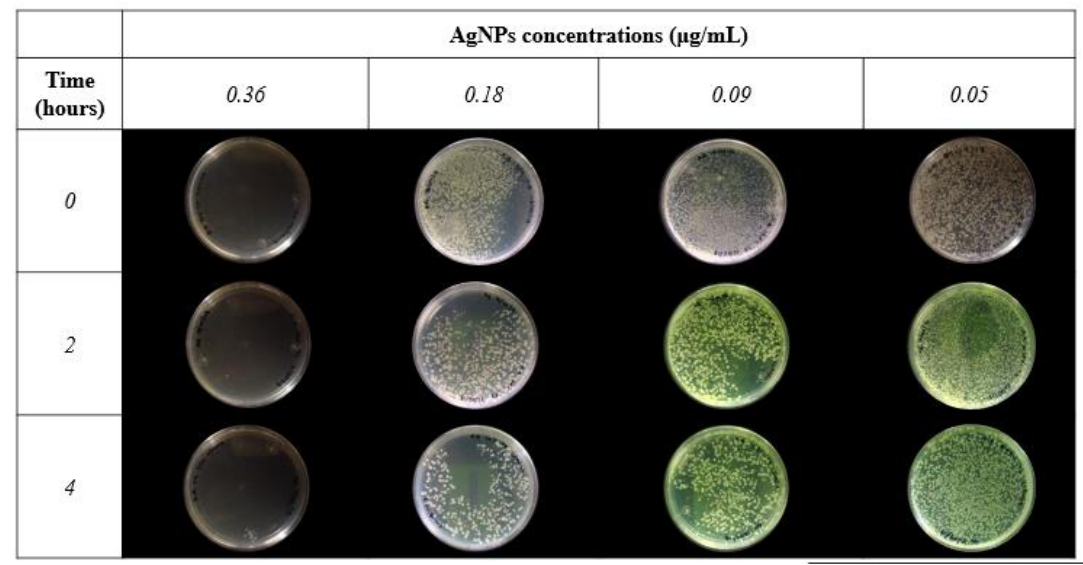
Figure 6. Matrix of P. aeruginosa cultures at different AgNP concentrations and incubation times. Table 2. Average cell concentrations of P. aeruginosa at different AgNP concentrations and incubation times.